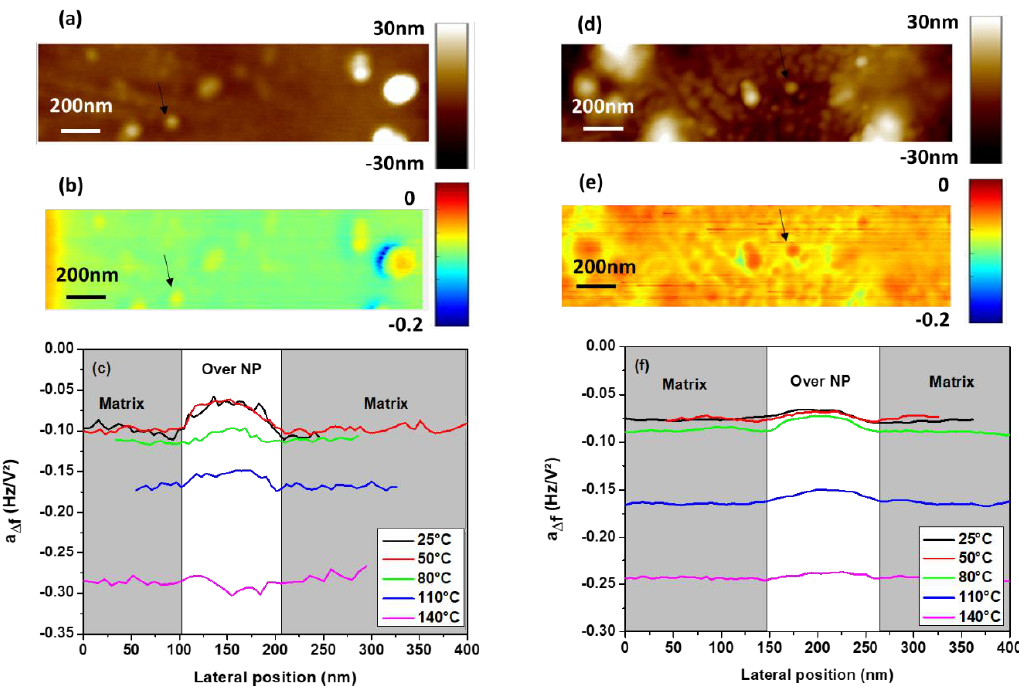
Figure 5. ( a ) Topography, ( b ) frequency shift parameter a Δf at 25 °C and ( c ) frequency shift parameter a Δf profiles at various temperatures for untreated Si 3 N 4 nanoparticles. ( d ) Topography, ( e ) frequency shift parameter a Δf at 25 °C and ( f ) frequency shift parameter a Δf profiles at various temperatures for treated Si 3 N 4 nanoparticles.